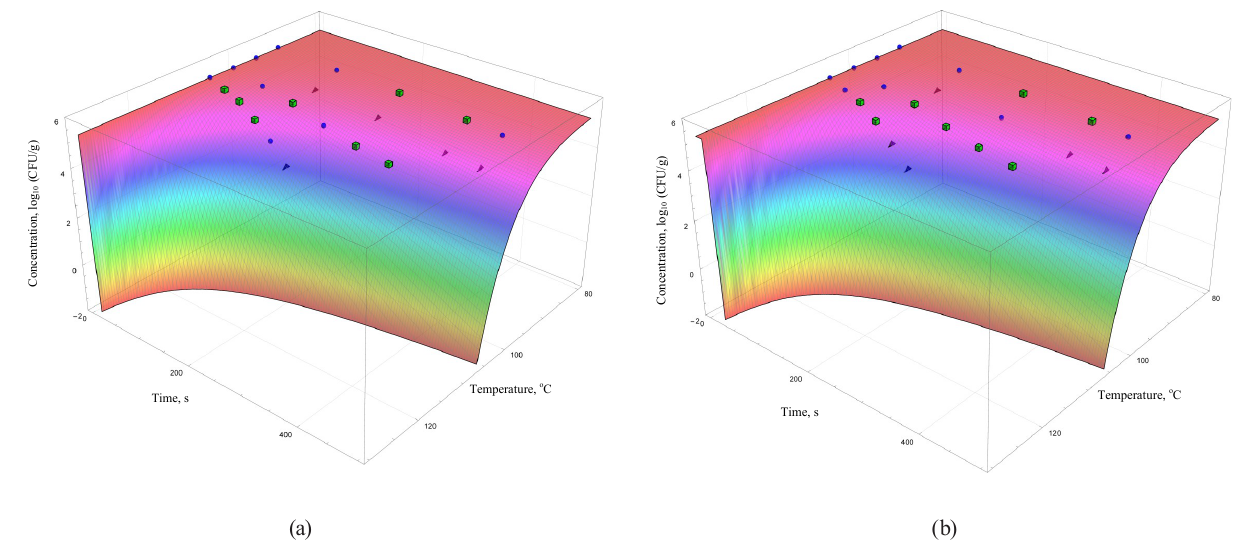
Figure 5 Secondary linear models of microbial death of A. acidoterrestris during heat treatment. (a) Bigelow model, (b) Whiting- Buchanan model